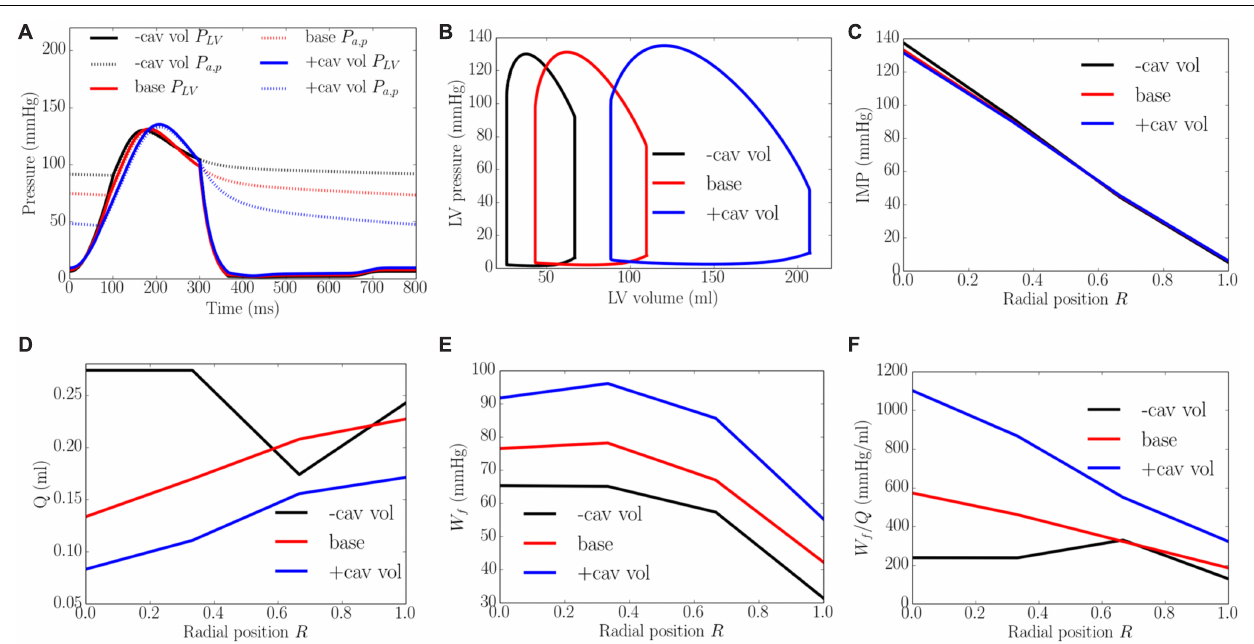
FIGURE 9 | Effects of cavity volume on (A) Pressure waveforms; (B) LV pressure-volume loop; Transmural distribution of (C) IMP; (D) Total coronary flow over a cardiac cycle; (E) Work density over a cardiac cycle W f ; (F) Work density-perfusion mismatch index ratio W f / Q . “-cav vol,” “base,” and “+cav vol” denote reduced cavity volume, baseline, and increased cavity volume